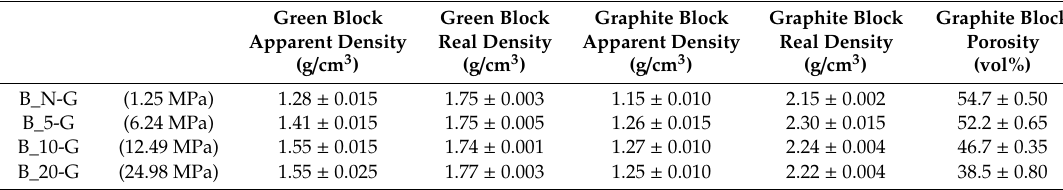
Table 1. Density and porosity of the carbon molded body.